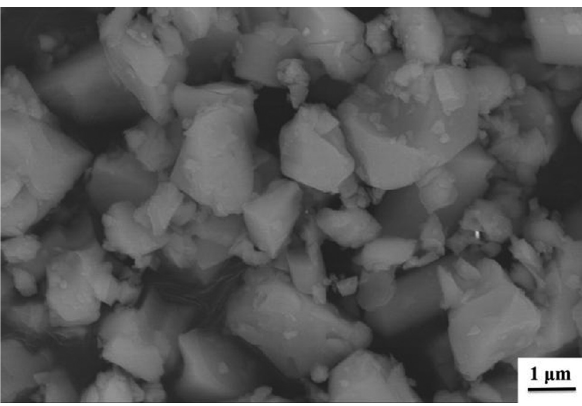
Figure 1: The SEM photograph of the β - Si 3 N 4